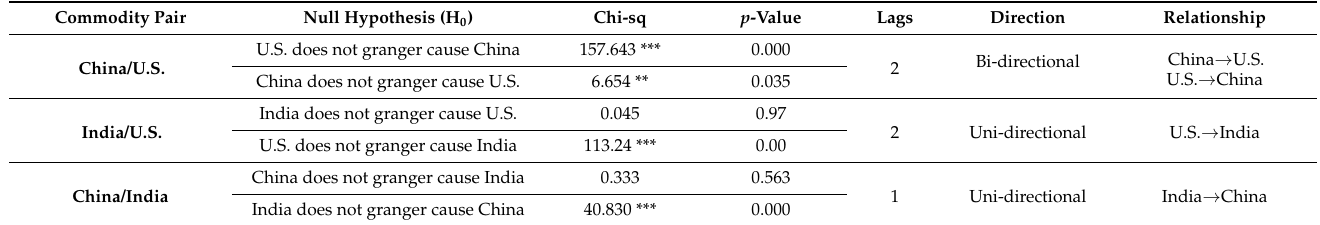
Table 6. Estimates of VEC Granger Causality Test of Three Cotton Markets.